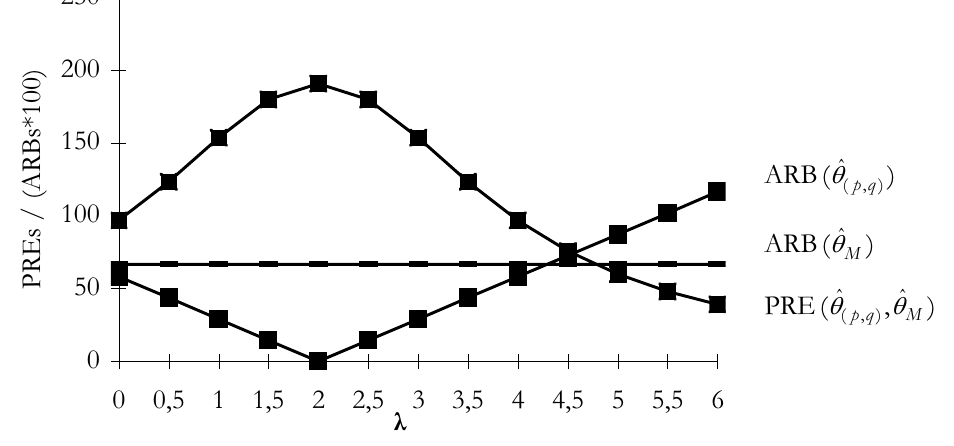
Figure 1 – Effect of departure of guessed value from true value on Percent Relative Efficiency and Absolute Relative Bias.